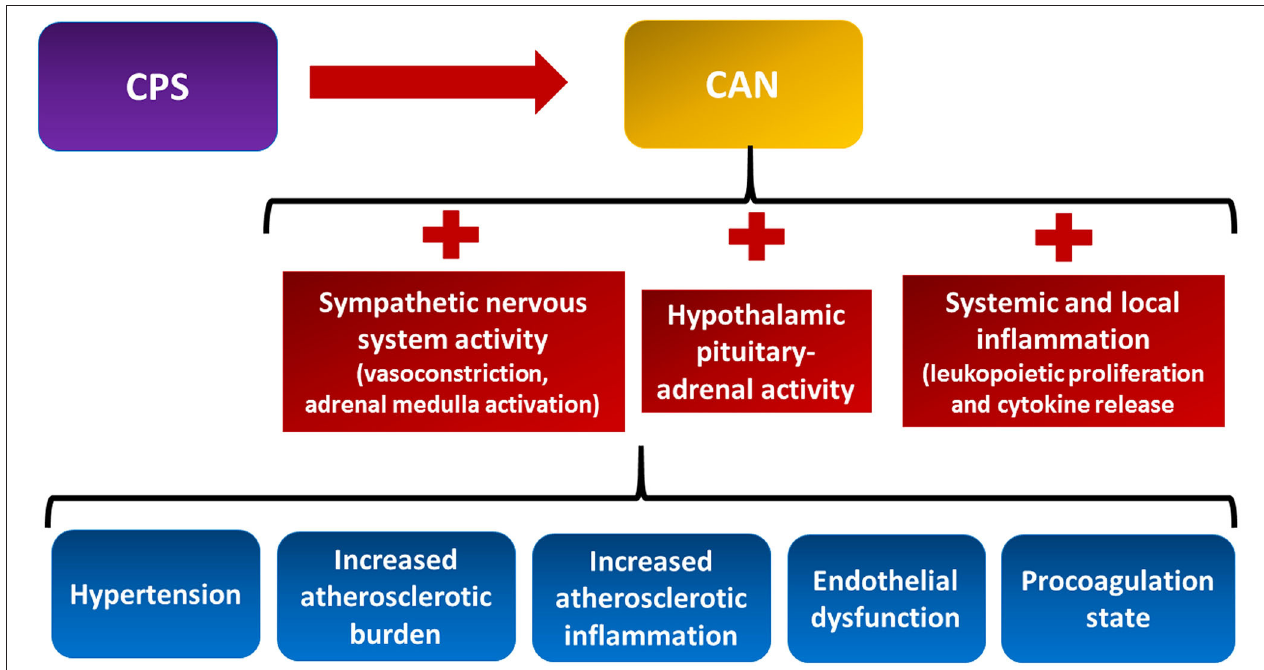
FIGURE 2 | The neuro–immune–arterial axis. It is the multisystem pathophysiological processes linking chronic psychological stress (CPS) and cardiovascular disease. CPS triggers dysregulation of the autonomic nervous system, the hypothalamic pituitary–adrenal axis, the local and systemic inflammation, and the coagulation system (see text for details). CAN, central autonomic